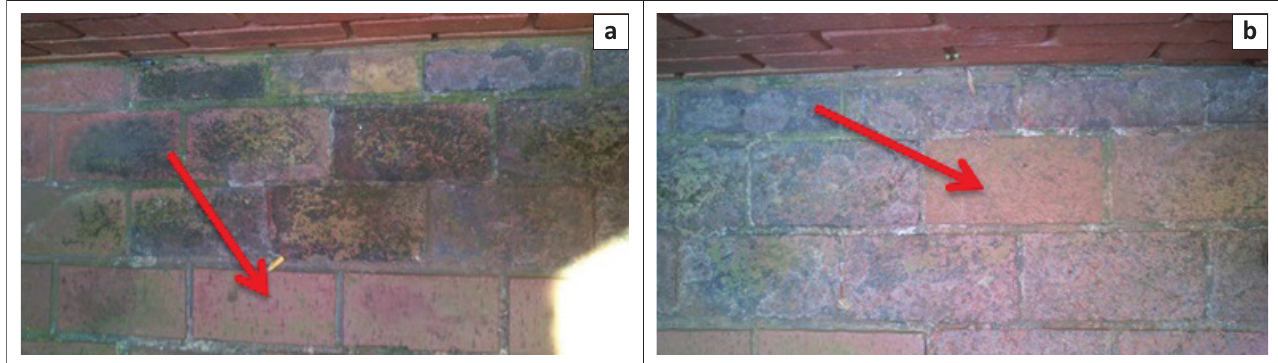
FIGURE 4: Some (a) pavement bricks with no presence of algae and some (b) pavement bricks with the presence of algae (pointed by red arrow).